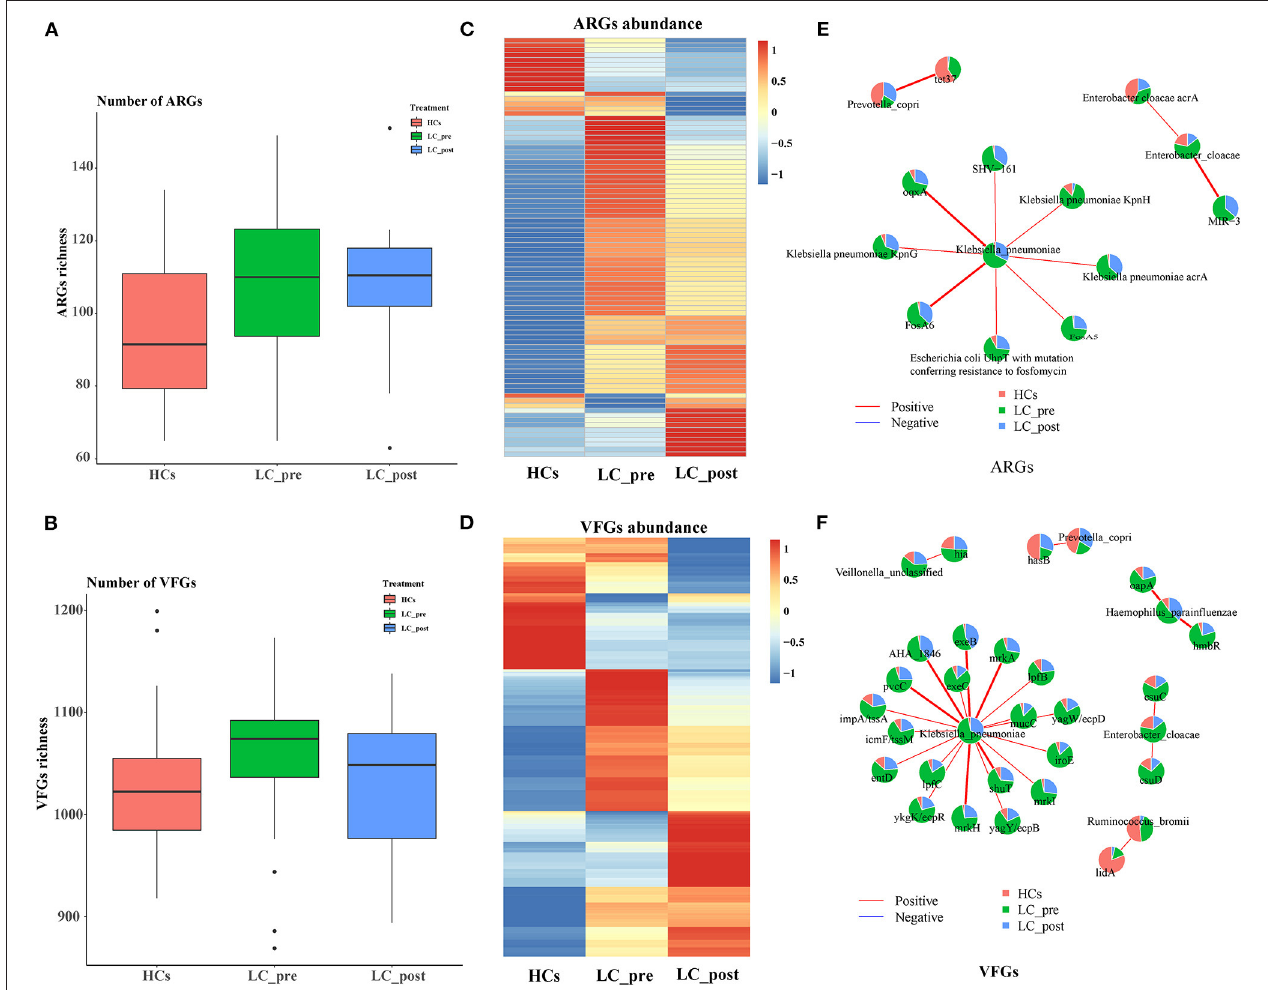
FIGURE 4 | Comparison of fecal ARGs and VFGs in subjects of cirrhotic patients before (LC-pre, green) and after (LC-post, blue) lactitol intervention and healthy controls (HCs, red), and correlation analysis between discriminatory genes and bacteria. (A) comparison of ARGs enrichment between the three groups. (B) Comparison of VFG enrichment between the three groups. (C) Heatmap of differential ARGs. (D) Heatmap of differential VFGs. (E) Correlation between ARGs and bacteria. (F) Correlation between VFGs and bacteria. Wilcoxon rank-sum test with a significance level of P < 0.05. ARGs, antibiotics resistance genes; VFGs, virulence factor